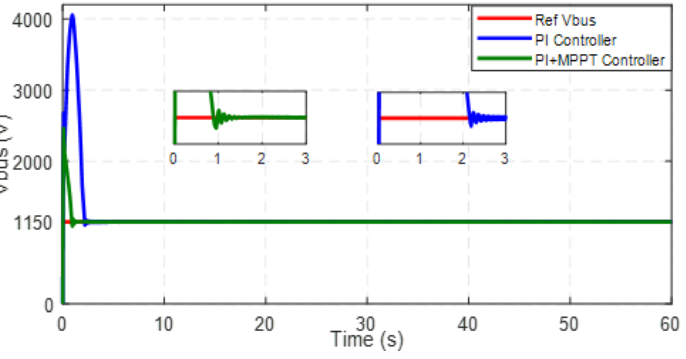
Figure 20. DC bus voltage of WECS.